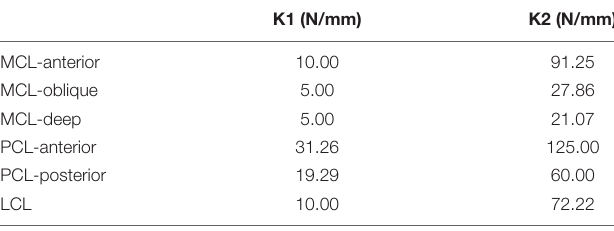
TABLE 1 | The stiffness coefficients of the ligaments in current